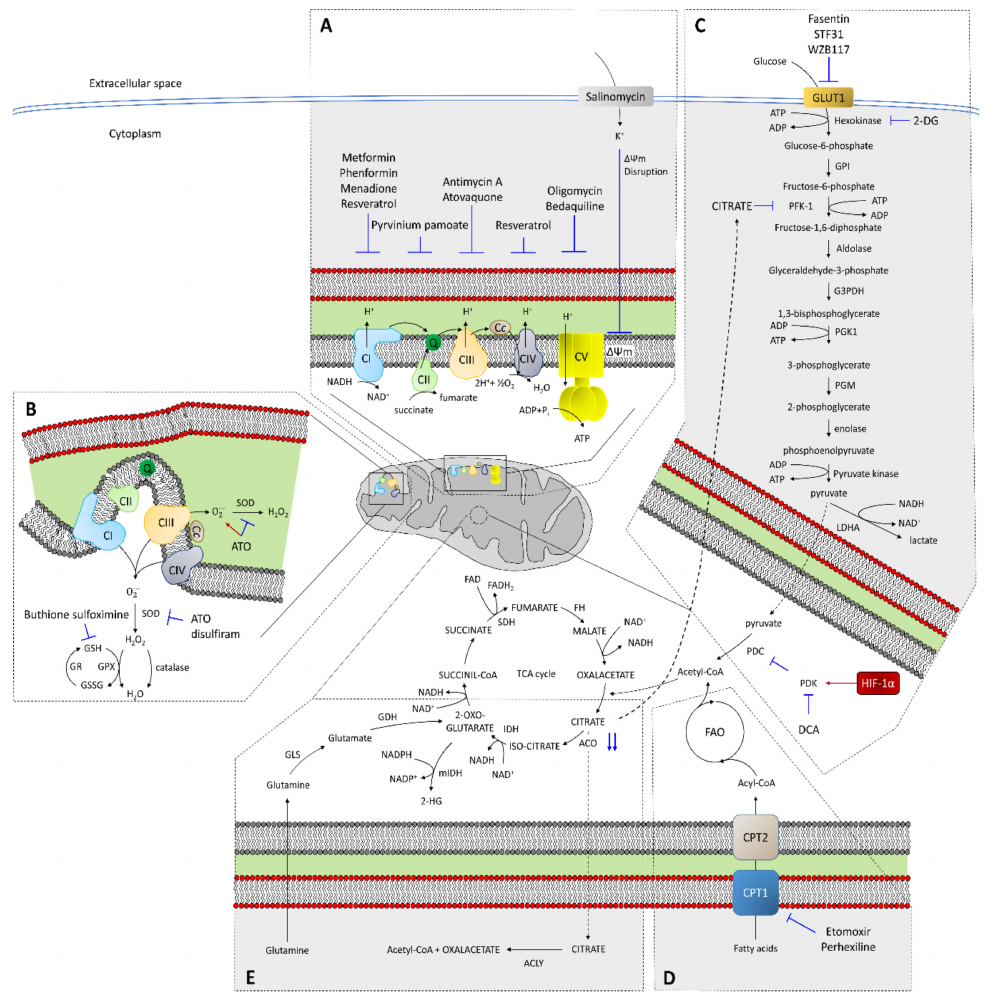
Figure 2. Mitochondrial metabolism targeting can overcome CSC resistance. ( A ) Mitochondrial eltron transport chain (ETC), core of oxidative metabolism, showing some of the described inhibitors for each complex (blue lines) used for CSC treatment. CI: complex I; CII: complex II; CIII: Complex III, CIV: Complex IV; CV: Complex V; Q: ubiquinone; C c : cytochrome c. Outer mitochondrial membrane appears in red, while inner mitochondrial membrane is colored in grey. Salinomycin causes mitochondrial membrane potential ( ∆Ψ m) disruption. ( B ) Reactive oxygen species produced as a consequence of ETC. Inhibitors of mitochondrial detoxifying enzymes are labelled with a blue line. Red arrow indicates a RNOS enhancer. ATO: Arsenic trioxide; GSH: glutathione; GSSG: glutathione disulfide; GR: glutathione reductase; GPX: gluthathione peroxidase. ( C ) Glycolytic metabolism, showing inhibitors of GLUT1 and hexokinase, blocking glycolysis at its beginning, and dichloroacetate (DCA), that inhibits pyruvate dehydrogenase kinase (PDK) and allow the incorporation of pyruvate into the tricarboxylic acid (TCA) cycle. Blue lines correspond to glycolytic inhibitors, while red arrows belong to HIF-1 α , a glycolytic enhancer. 2-DG: 2-deoxyglucose; GPI: glucose-6-phosphate isomerase; G3PDH: glyceraldehyde-3-phosphate dehydrogenase; PGK1: phosphoglycerate kinase; PGM: phosphoglycerate mutase. ( D ) Summary of fatty acid oxidation (FAO) metabolism. Etomoxir and perhexiline, inhibitors of CPT1 (blue line) diminished CSC population, by reducing mitochondrial incorporation of fatty acids. ( E ) Pathways related to the TCA cycle frequently modified in CSCs. Blue arrows correspond to aconitase (ACO) knockdown. SDH: succinate dehydrogenase; FH: fumarate hydratase; IDH: isocitrate dehydrogenase; mIDH: mutated IDH. GLS: glutaminase; GDH: glutamate dehydrogenase; IDH: isocitrate dehydrogenase; ACLY: ATP citrate